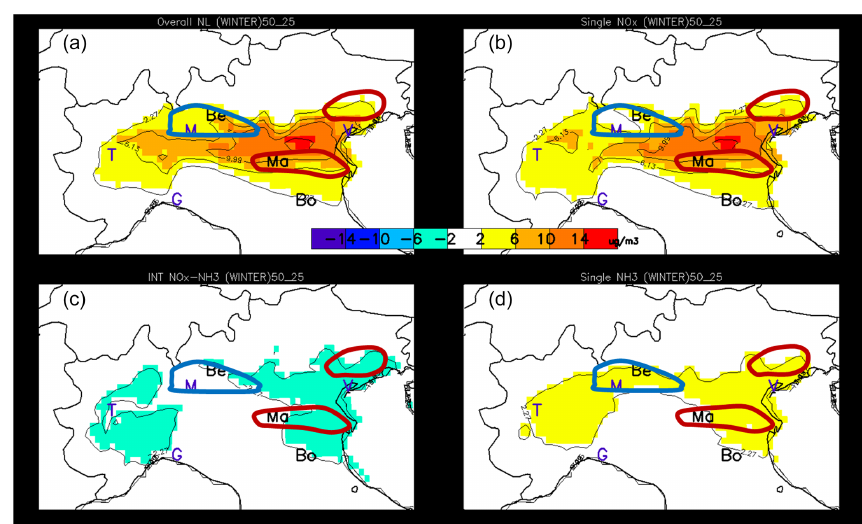
Figure 9. Wintertime maps of the overall non-linearity term (a) and of its components expressed as potential impacts between 25% and 50%: the single NO x non-linearity term (a, b) , the single NH 3 non-linearity term (d) and the NO x –NH 3 interaction term (c) . The three locations of interest, Bergamo, Mantua and Bologna, are indicated by their first two letters, while other cities are indicated with their first letter for convenience (Venice, Milan, Turin and Genoa). The hand-drawn contours roughly indicate the central position of the NH 3 (blue) and NO x (red) sensitive regime areas (see Fig. 3 – right).